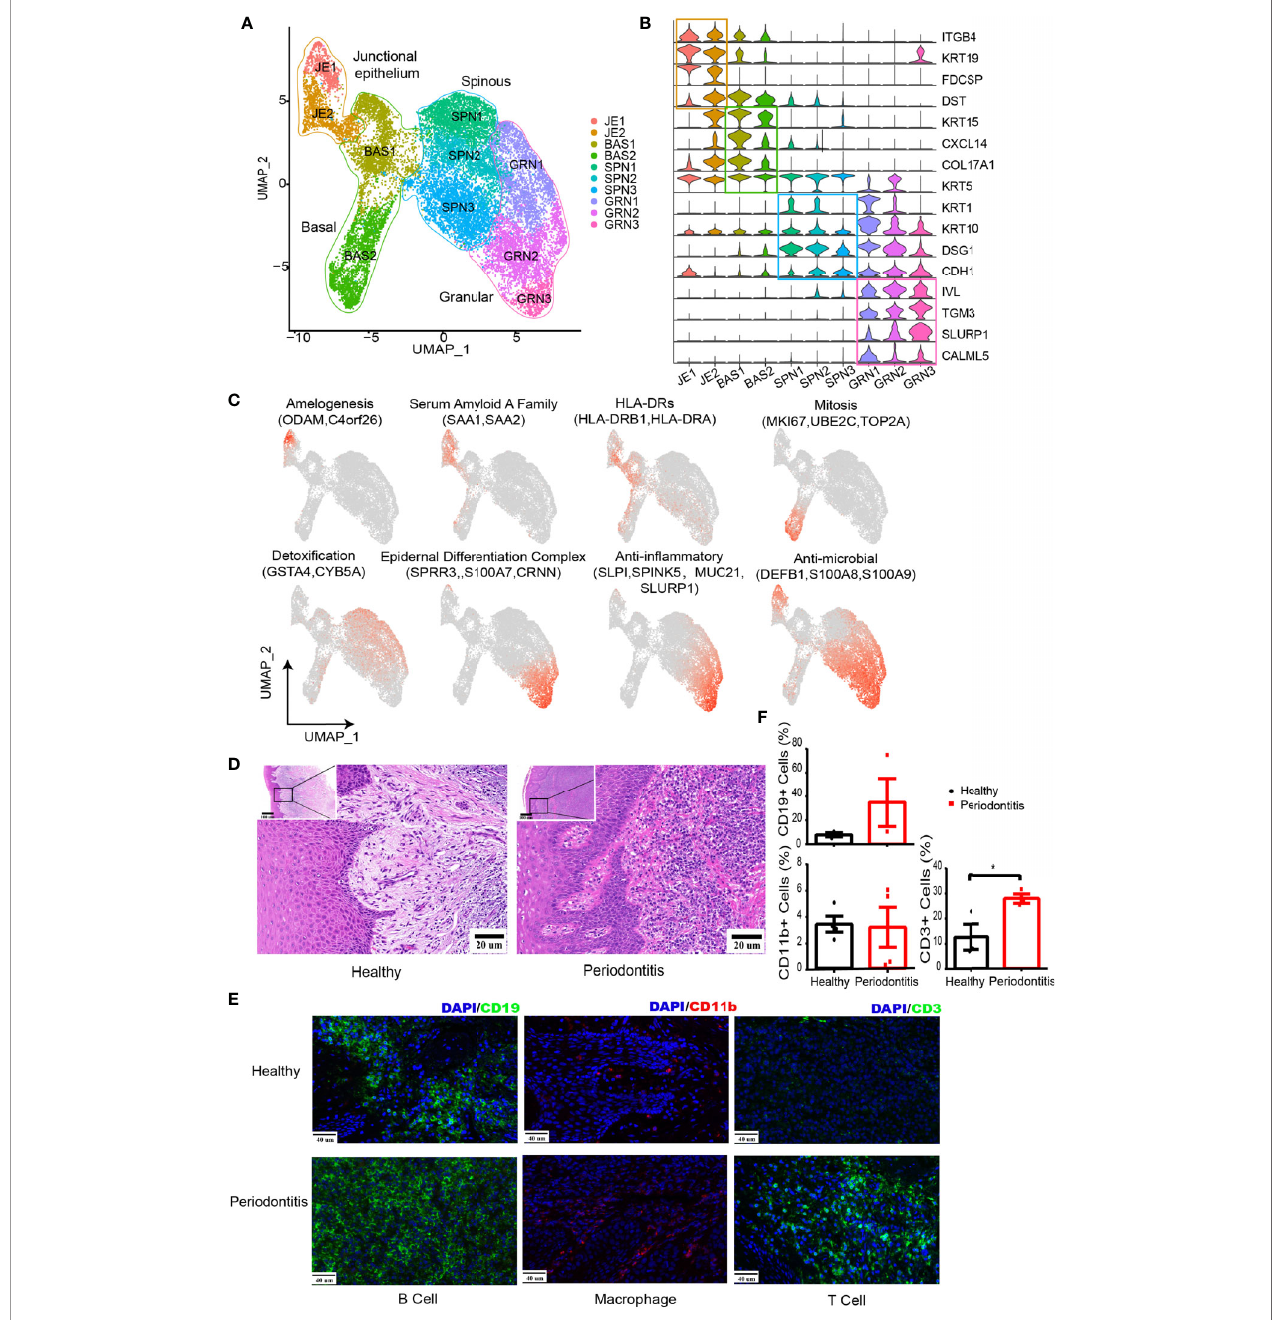
FIGURE 2 | Changes in the microenvironment within human gingival tissue in periodontitis. (A) UMAP representation for human gingival epithelial cells in the combined health ( n = 2; 18,012 cells) and periodontitis ( n = 2; 502 cells) dataset. (B) Violin plots showing expression levels of cluster-de fi ning genes for epithelial subsets. Expression values are normalized and scaled averages. (C) UMAP plots displaying functional molecule scores in the epithelial cells of all subpopulations. Red indicates maximum expression, and grey indicates low or no expression of each particular set of genes in log-normalized UMI counts. (D) H&E staining of the representative gingival tissue from health (left) and periodontitis (right) sections. Scale bar: 20 m m. (E) Representative immuno fl uorescence (IF) staining for CD19 + B cells (green, one column), CD11b + macrophages (red, two columns), and CD3 + T cells (green, three columns) with DAPI (blue) in gingival sections of healthy (top) and periodontitis patients (bottom). Images were acquired at ×40 magni fi cation (scale bar: 40 µm). (F) Bar graphs demonstrate percentage of CD19 + B cells (left top), CD11b + macrophages (left bottom), and CD3 + T cells (right bottom) in gingival sections of healthy ( n = 4) and periodontitis patients ( n = 4) based on immuno fl uorescence analysis. The number of cells is counted based on fi ve different limited areas on a slide from one sample then the mean was calculated. One dot per individual. Small horizontal lines indicate the mean (± s.d.). * p ≤ 0.05, as determined by Student ’ s t